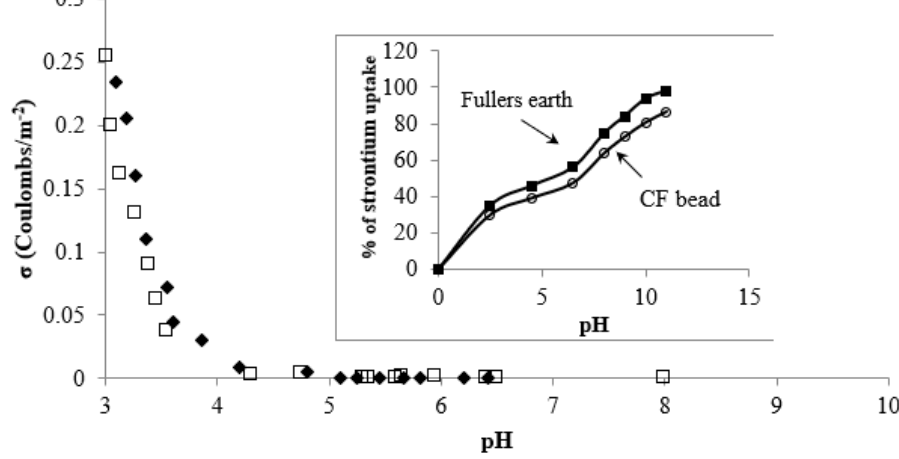
Figure 3. Surface charge analysis of the CF beads in ( ♦ ) 0.1 M and ( □ ) 0.05 M NaNO 3 solution. Effect of pH on strontium adsorption onto the CF beads (Inset). Healthcare 2019 , 6 , x FOR PEER REVIEW